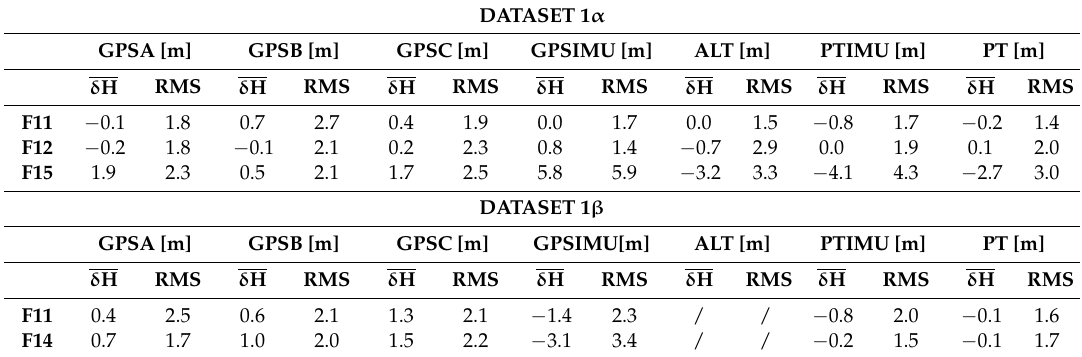
Table 3. Average residuals δ H J and RMS ( δ H J ) for data acquired at 1 Hz in the range (35–340) m (DATASET 1 α ) and in the range (340–2194) m (DATASET 1 β